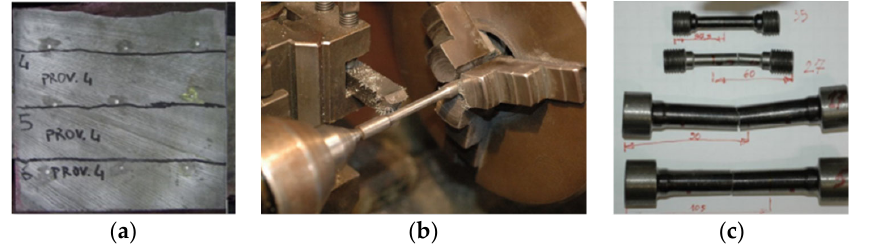
Figure 3. Different phases of the production and testing of the standardized specimens: ( a ) splitting of the cube into specimens; ( b ) machine tool processing of the ‘dog bone’ shapes; ( c ) specimens after failure.